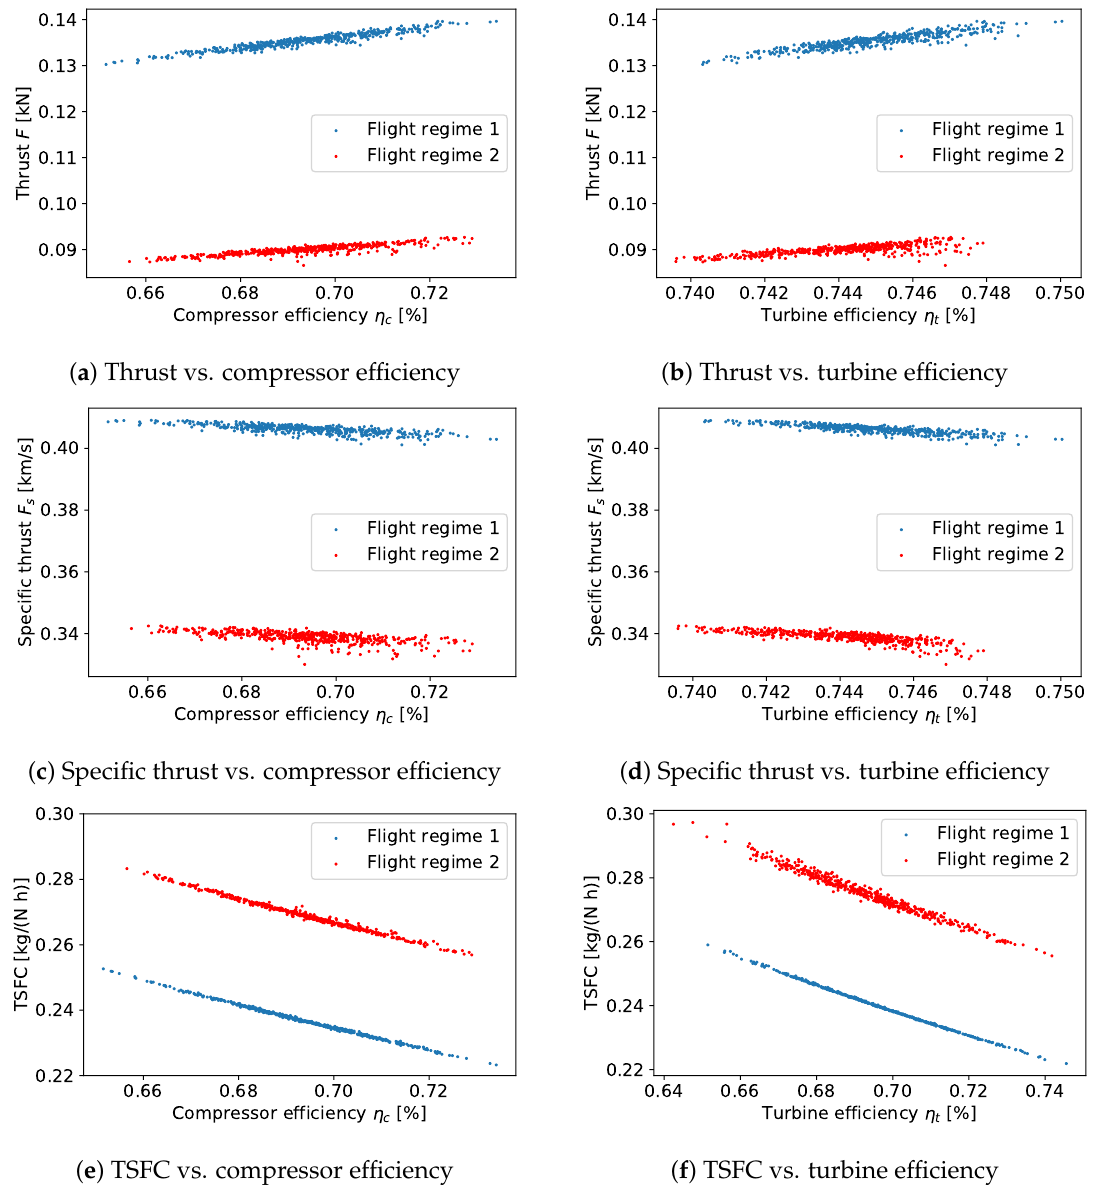
Figure 5. Thrust and TSFC vs. compressor or turbine efficiency η c at sea level (flight regime 1) and cruise conditions (flight regime 2) for different degradation